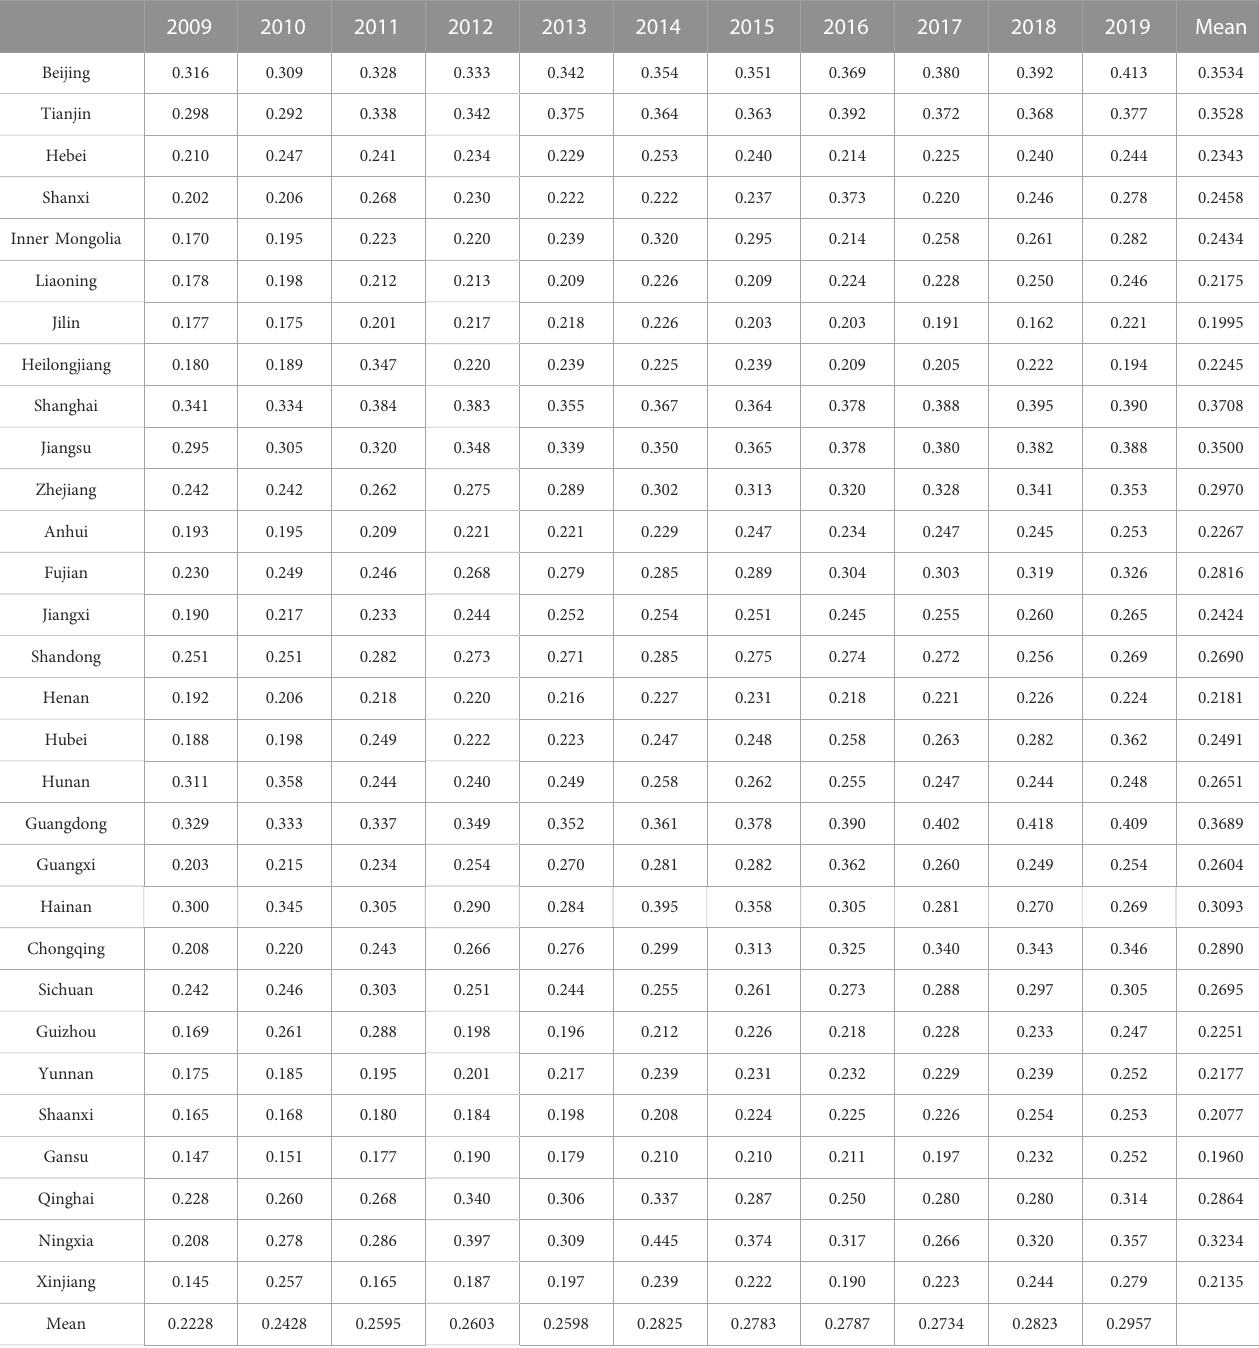
TABLE 4 Provincial levels of